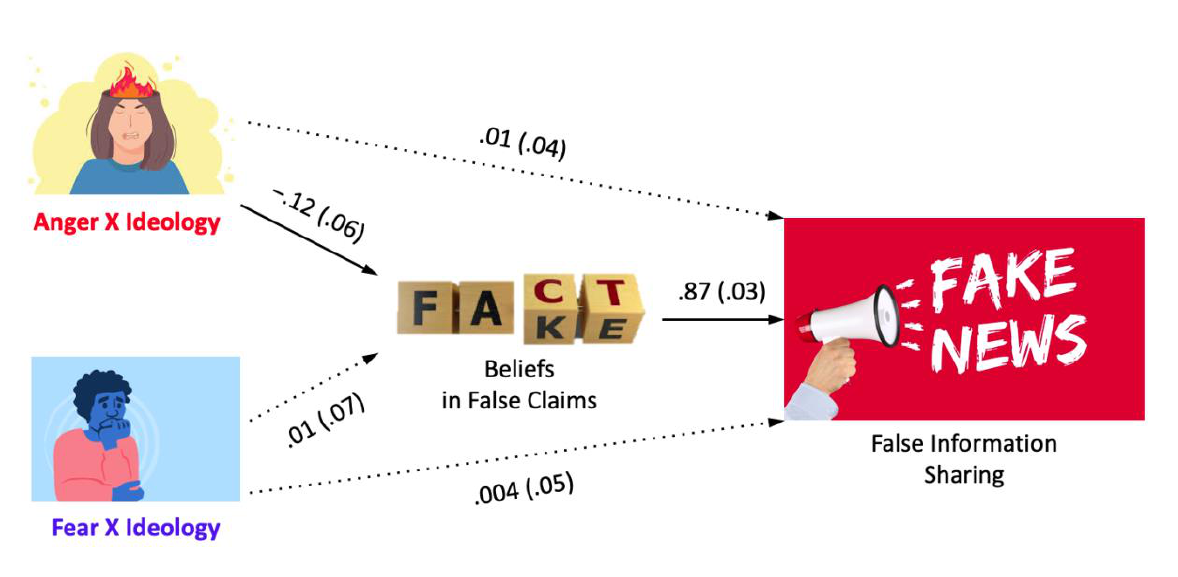
Figure 2 . The indirect effect of anger and fear moderated by political ideology on misinformation sharing via beliefs in false claims. Estimates are reported as unstandardized (standard error). Solid lines indicate significant regression coefficients at the alpha level of .05. Dotted lines indicate insignificant regression